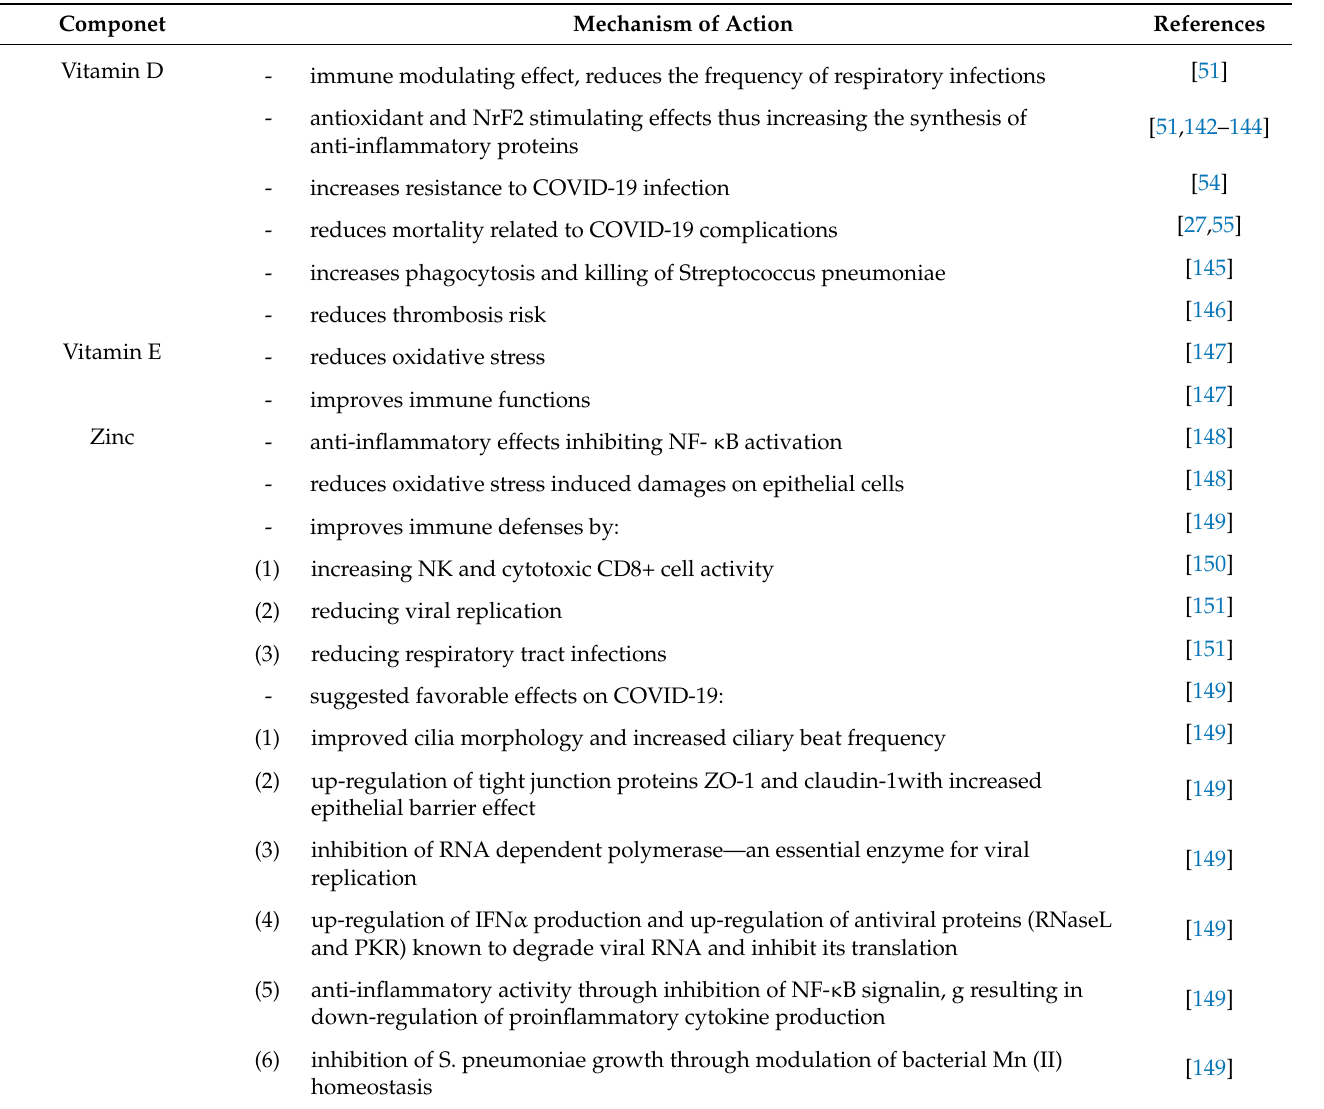
Table 1. Vitamins, oligoelements, flavonoids, and polyphenols: their antiviral, anti-inflammatory, and antioxidant activities and their preventive effects against viral infections and their long-term